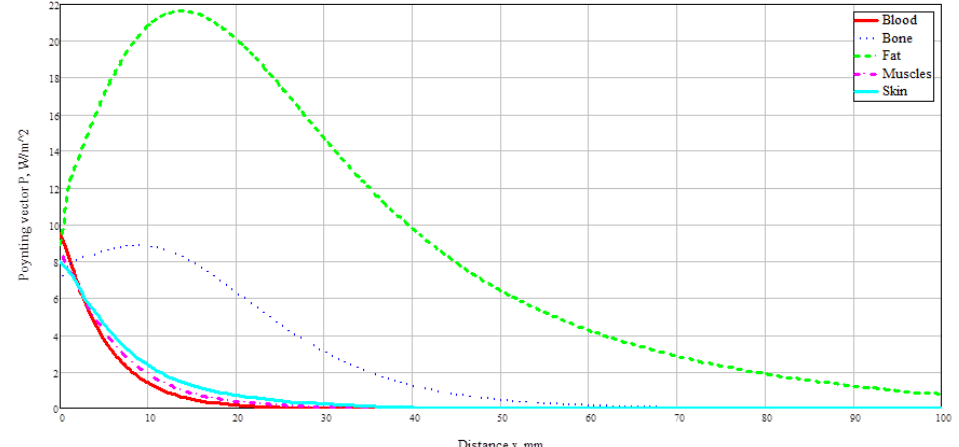
Figure 3. Attenuation of the near-field flux power density of the probe radiation in biological tis- sues.